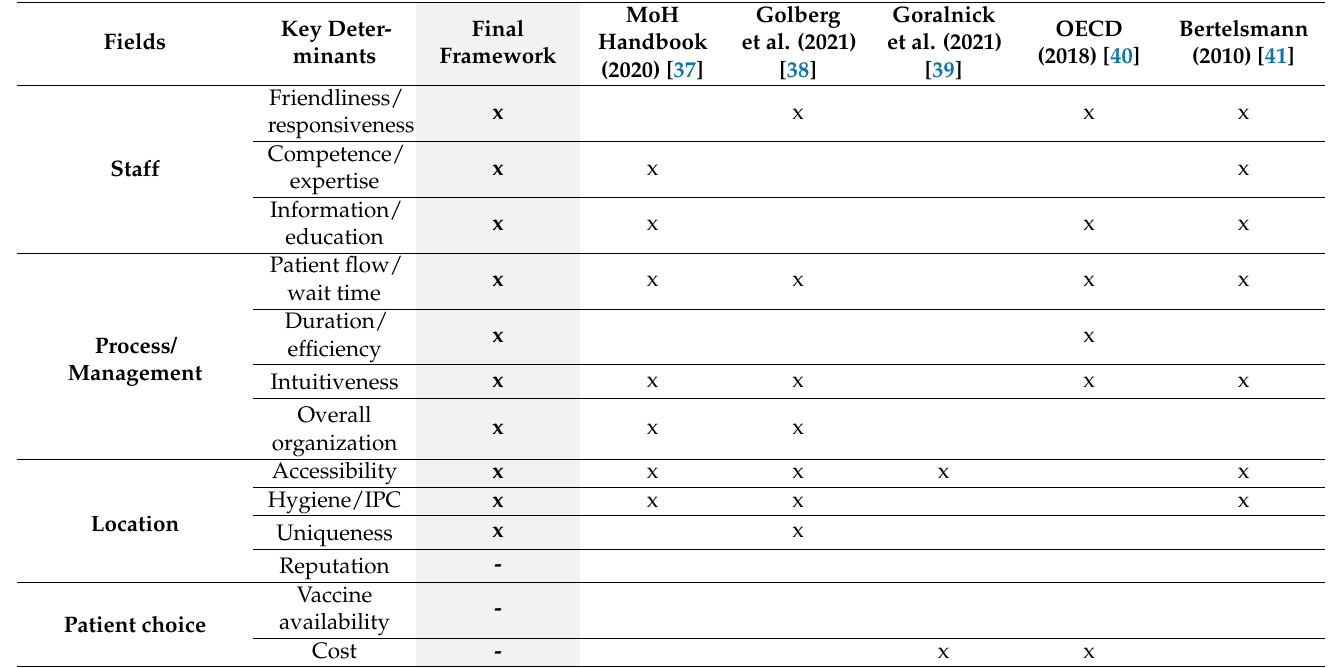
Table A2. Key determinants of user experience as proposed in publications on vaccination centers or reference publications on patient reported experience measures (PREMs) and patient reported outcome measures